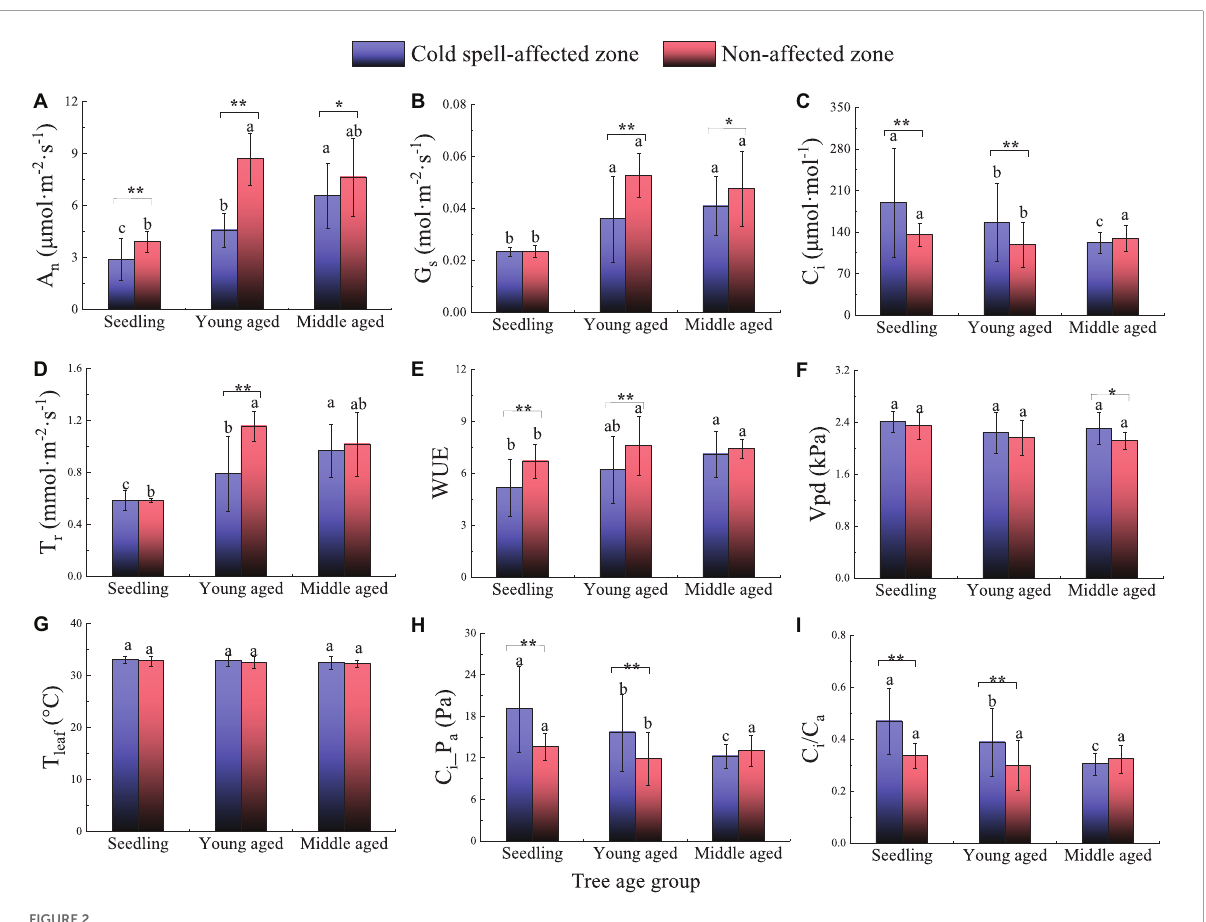
FIGURE2 Leaf gas exchange of Chinese tallow in the cold spell impacted and non-impacted zones by cohort. Different lowercase letters indicate significant differences between cohorts ( P < 0.05). Asterisks with brackets indicate significant differences between cold spell impact zone and non-impacted zone within the cohort (* P < 0.05; ** P < 0.01). (A) leaf net photosynthesis rate (A n ); (B) stomatal conductance (G s ); (C) intercellular CO 2 concentration (C i ); (D) transpiration rate (T r ); (E) water use efficiency (WUE); (F) vapor pressure deficit (V pd ); (G) leaf temperature (T leaf ); (H) the ratio of intercellular CO 2 concentration to air CO 2 concentration (C i /C a ); (I) intercellular CO 2 pressure (C i -P a